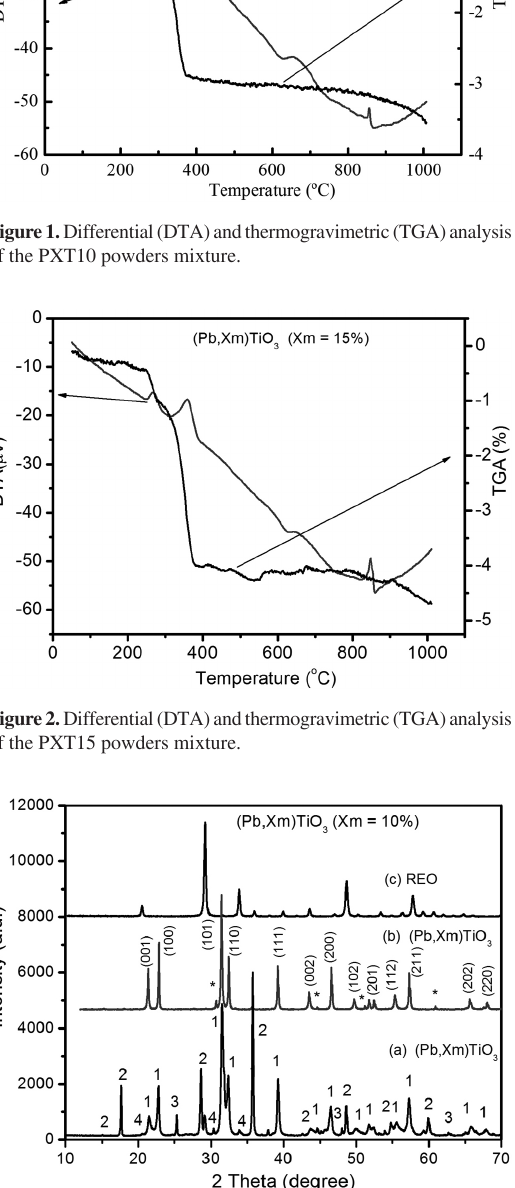
Figure 3. X-ray diffraction pattern of the powders: (a) PXT10 calcined at 550 °C, where (1) identifies PXT phase; (2) PbO; (3) TiO ; (4) Y O ; (*) pyroclore phase; (b) PXT10 calcined at 1150 °C 3 2 3 and (c) Rare Earth Elements of Xenotime